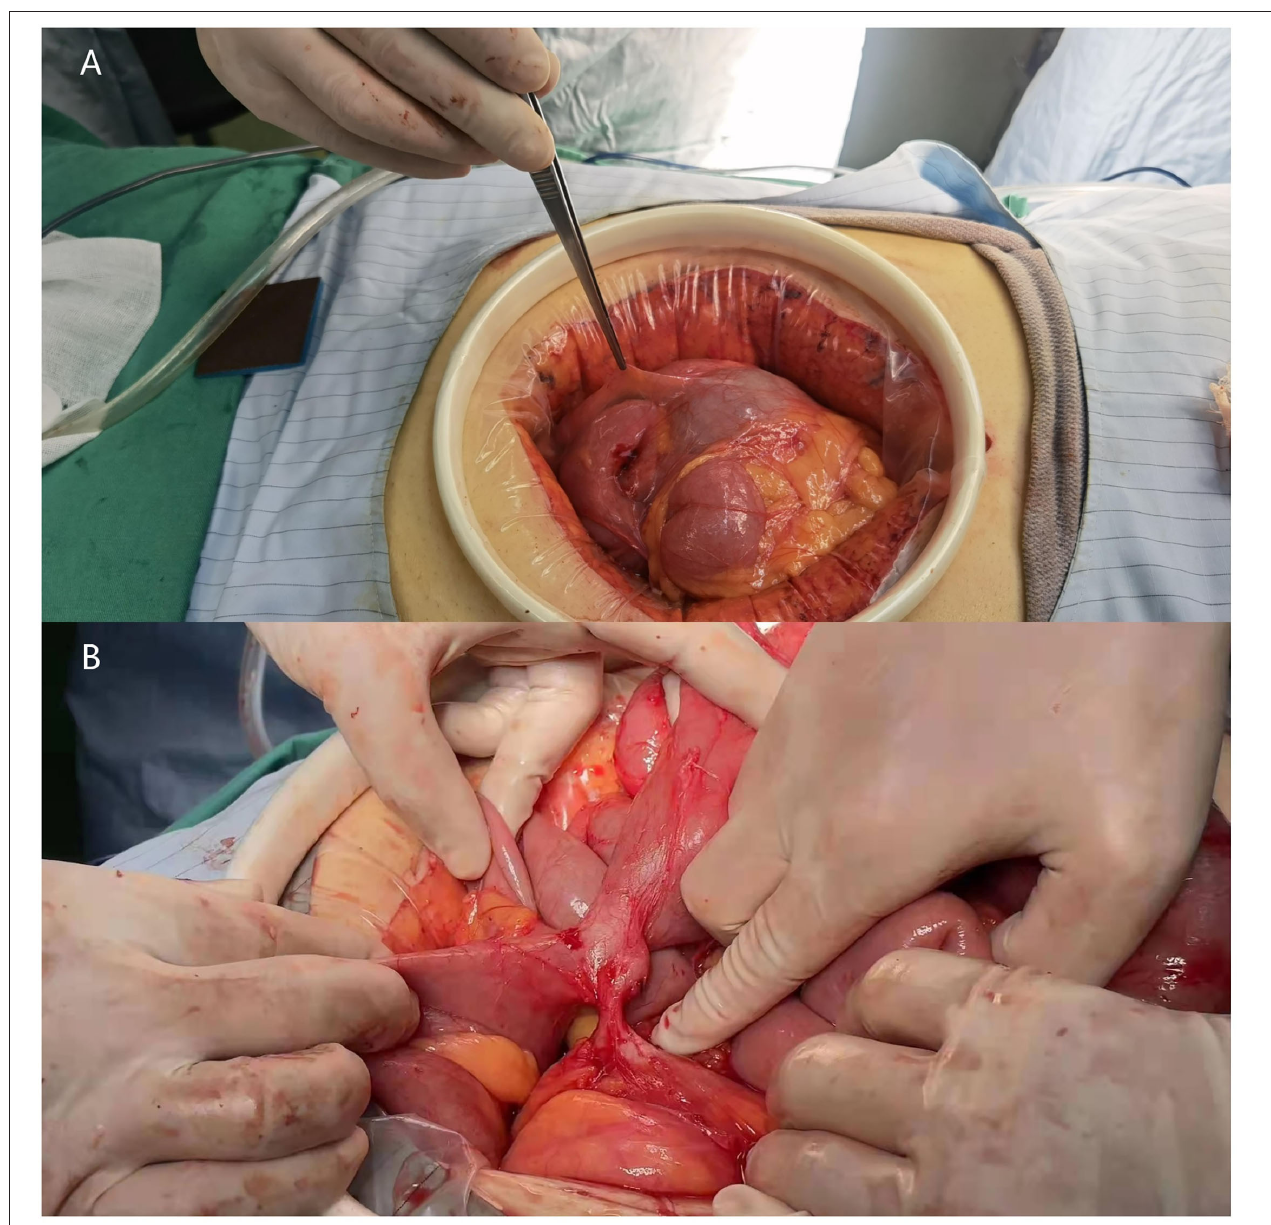
FIGURE 3 | Photographs of the surgery scene. (A) Part of the small intestine is wrapped by a fibrous membrane and is folded into a mass. (B) jejuno-ileo-colonic